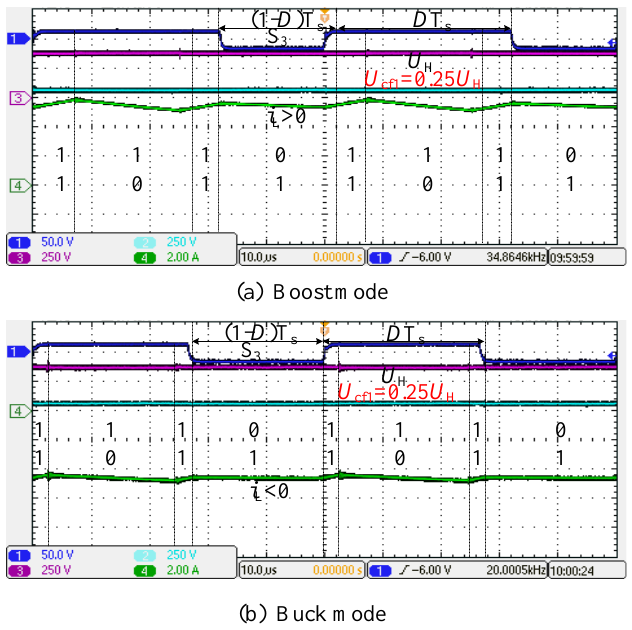
Figure 9. Left and right arms interleaved 90 º parallel with circumferential inhibition. ( a ) Boost mode, ( b ) Buck mode.